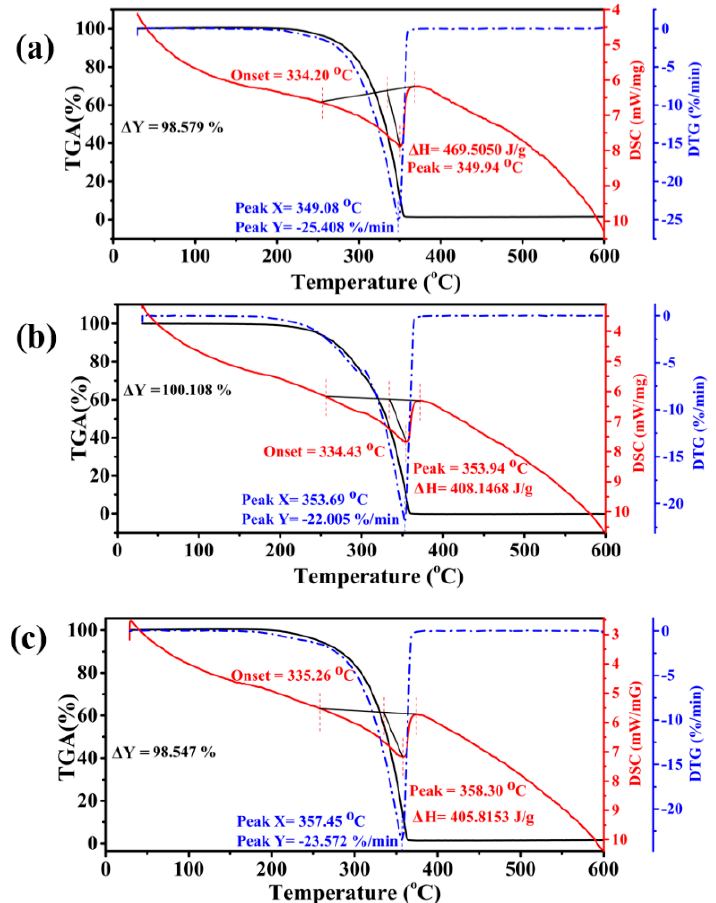
Figure 10. TGA − DSC − DTG curves of ( a ) pure synthetic ester, ( b ) SE/CdS, and ( c ) SE/Co 3 O 4 , at a heating rate of 10 °C/min in N 2 .